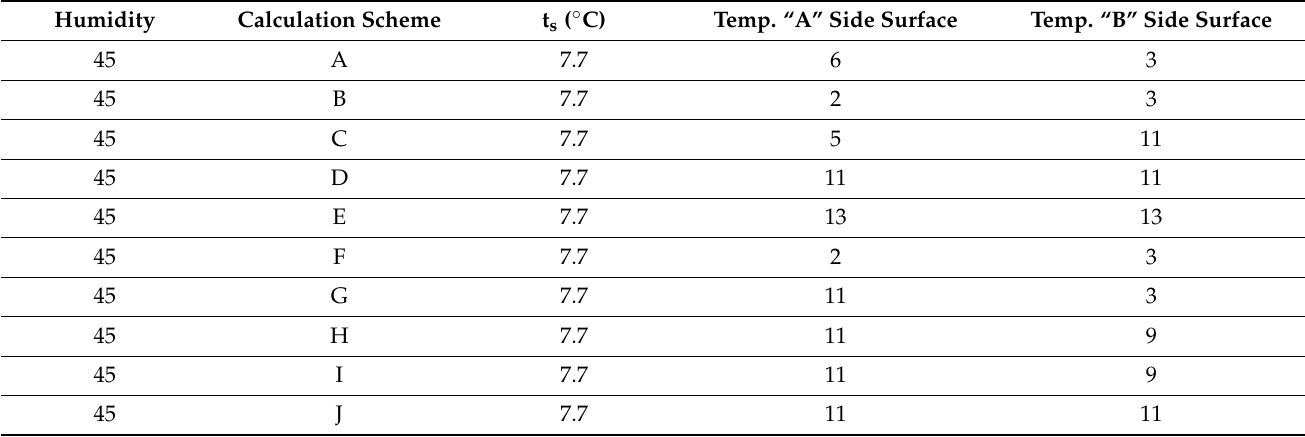
Table 3. Summary of data for analysis.